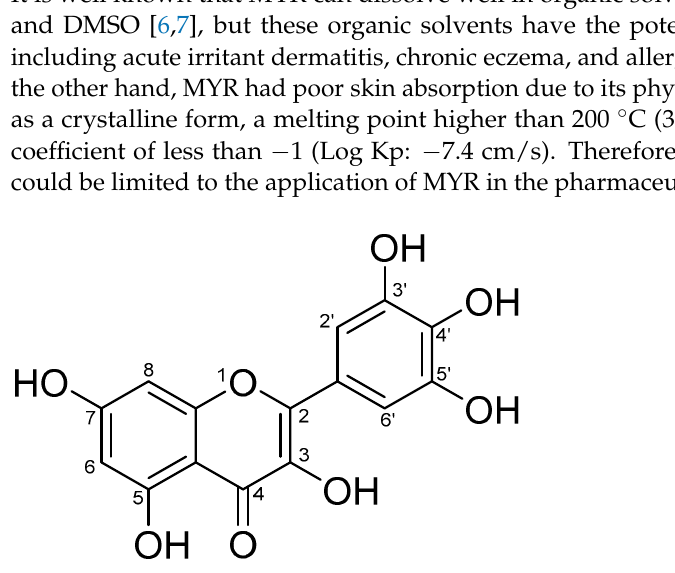
Figure 1. Chemical structure of myricetin (3, 3 ′ , 4 ′ , 5, 5 ′ , 7-hexahydroxyflavone).